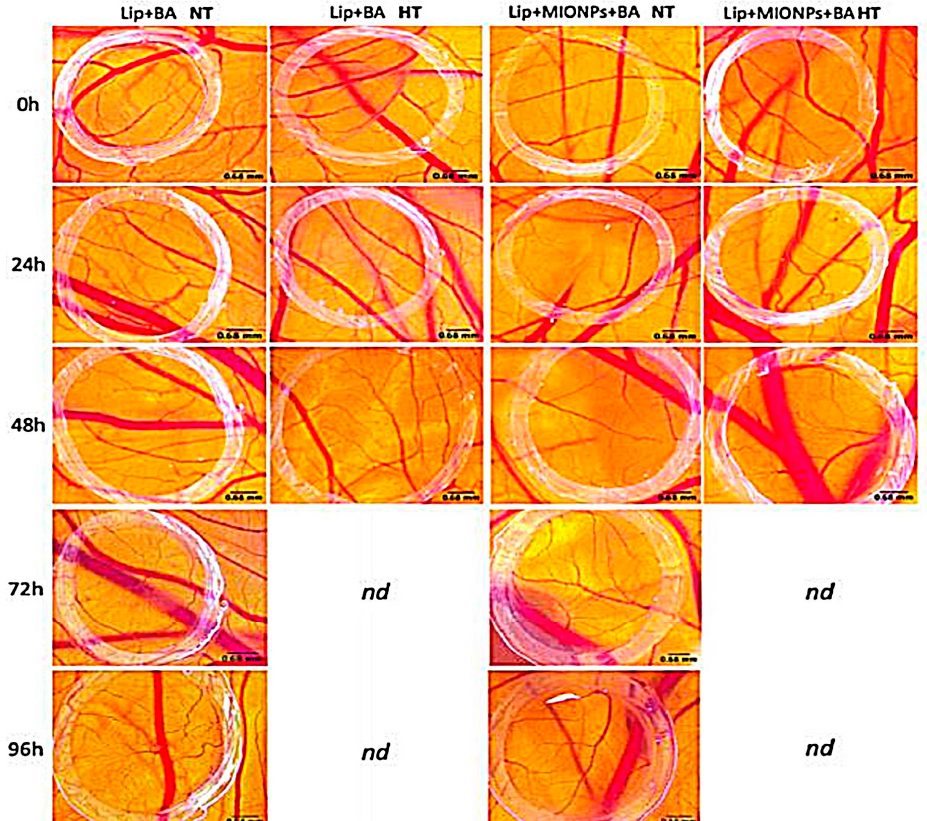
Figure 5. Stereo-microscopic in vivo images of the areas containing vessels treated with naked liposomes containing betulinic acid (BA) (Lip + BA) and the hybrid liposomal system (Lip + MIONPs*CA + BA) at a concentration of 25 μ M, under normothermic (NT = 37 °C) and hyperthermic condition (HT = 46 °C). The specimens treated with high temperature died after 48 h; thus, they were not determined (nd) further [76]. Reproduced with permission from Farcas et al., International Journal of Nanomedicine; published by Dove medical press, 2020. Continuing with the magneto-liposomes platform, Cardoso et al. developed two systems: stealth (PEGylated) and non-PEGylated magneto-liposomes containing calci-